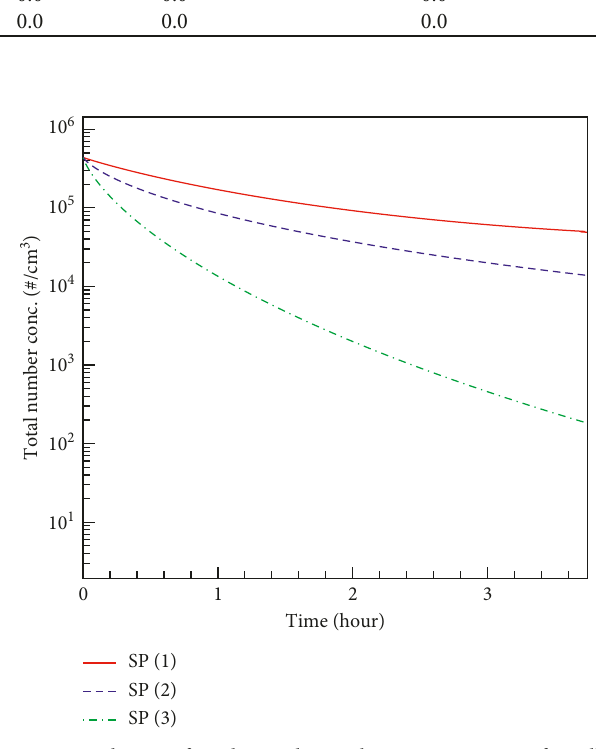
Figure 2: Change of total particle number concentration of small modes in the presence of large mode. At the same large mode, the total particle number concentration decreases more quickly for small modes with smaller size than those with larger size by BP mode and SP mode